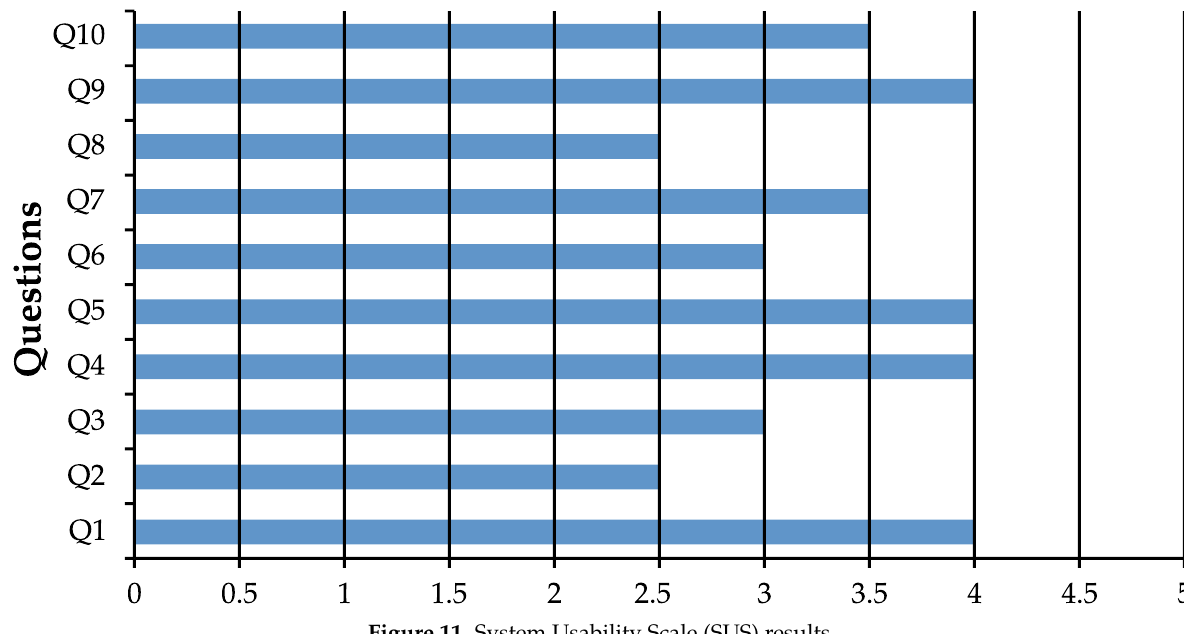
Figure 11. System Usability Scale (SUS)